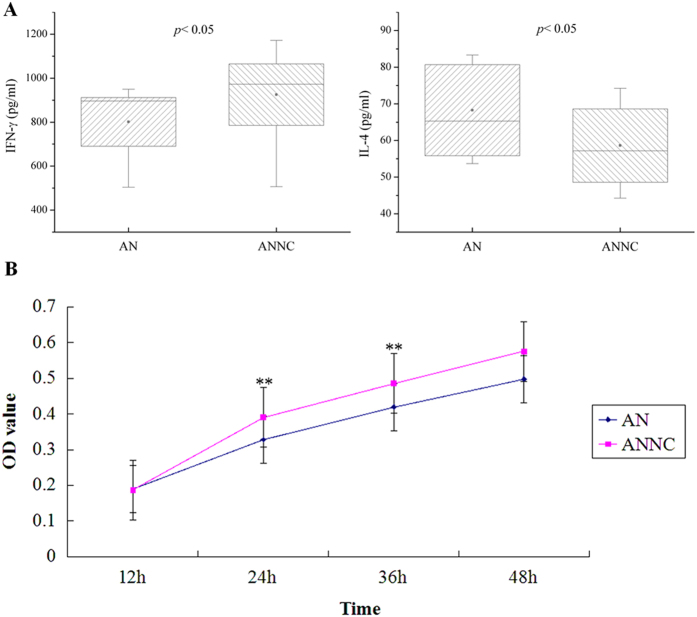
The proliferation activity as well as the IFN-γ and IL-4 levels in supernatant of EOLP CD4+ T cells transfected with antagomir-155.(A) The significant differences of IFN-γ and IL-4 levels were tested by independent-samples t test, and results are represented as box plots. AN represented the antagomir-155 transfected group, and ANNC was the corresponding negative controls. Statistical significances are shown in the blanks. (B) The solid dots and or cube separately showed the mean value of proliferation activity of EOLP CD4+ T cells in two groups at different time point, and the lines stretching from the dot or cube indicated extreme values. For each time point, independent-samples t test was used to determine differences between the two groups, in addition, “*”, “**” represent p < 0.05 and p < 0.01, respectively.